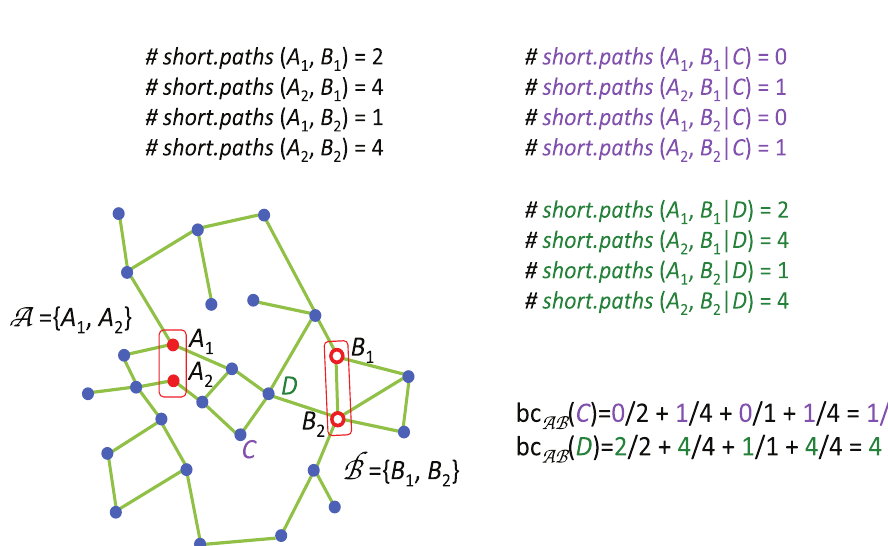
Figure 7. In this example we show how to calculate the distance (length of shortest path) between the gene G D